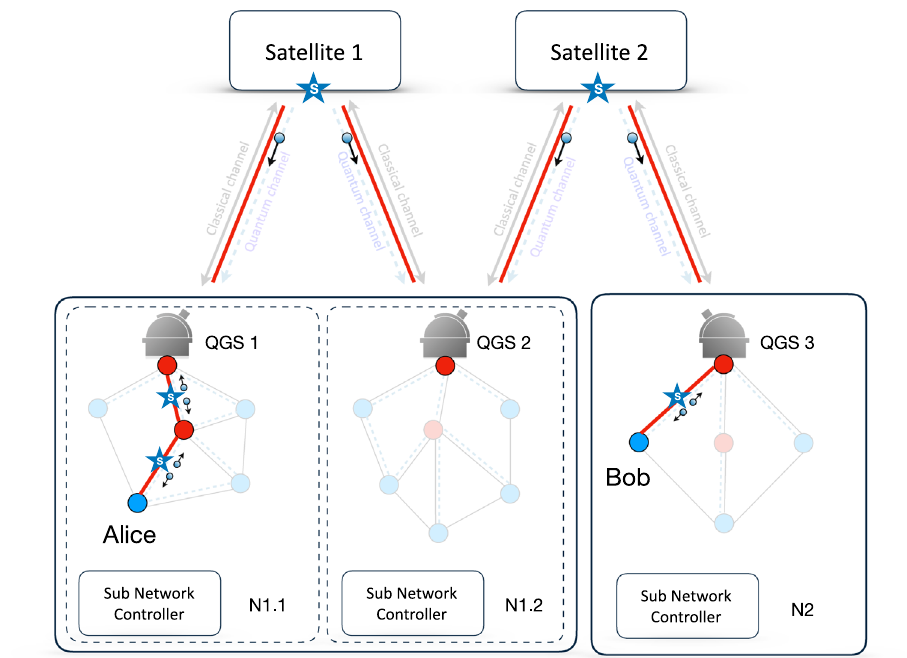
Fig. 3 Example of the establishment of a possible connection (red lines) between two QIN end-users, Alice and Bob (blue dots). The example involves multiple entanglement swappings between ground network (end-) nodes (blue and red dots) through entangled photon pair sources (blue stars) and two satellite-mediated connections between quantum optical ground station nodes in the